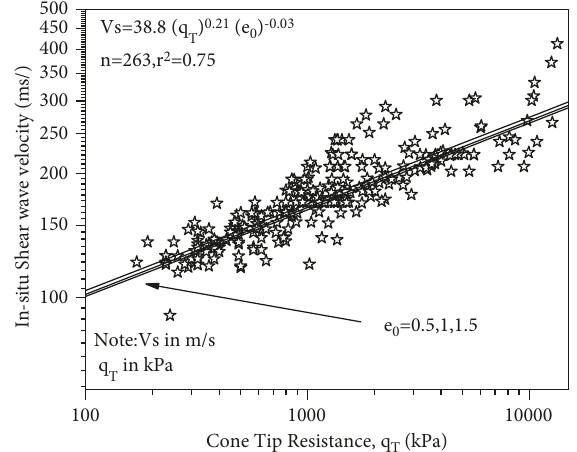
Figure 13: Shear wave velocity-cone tip resistance- e at Sites A and